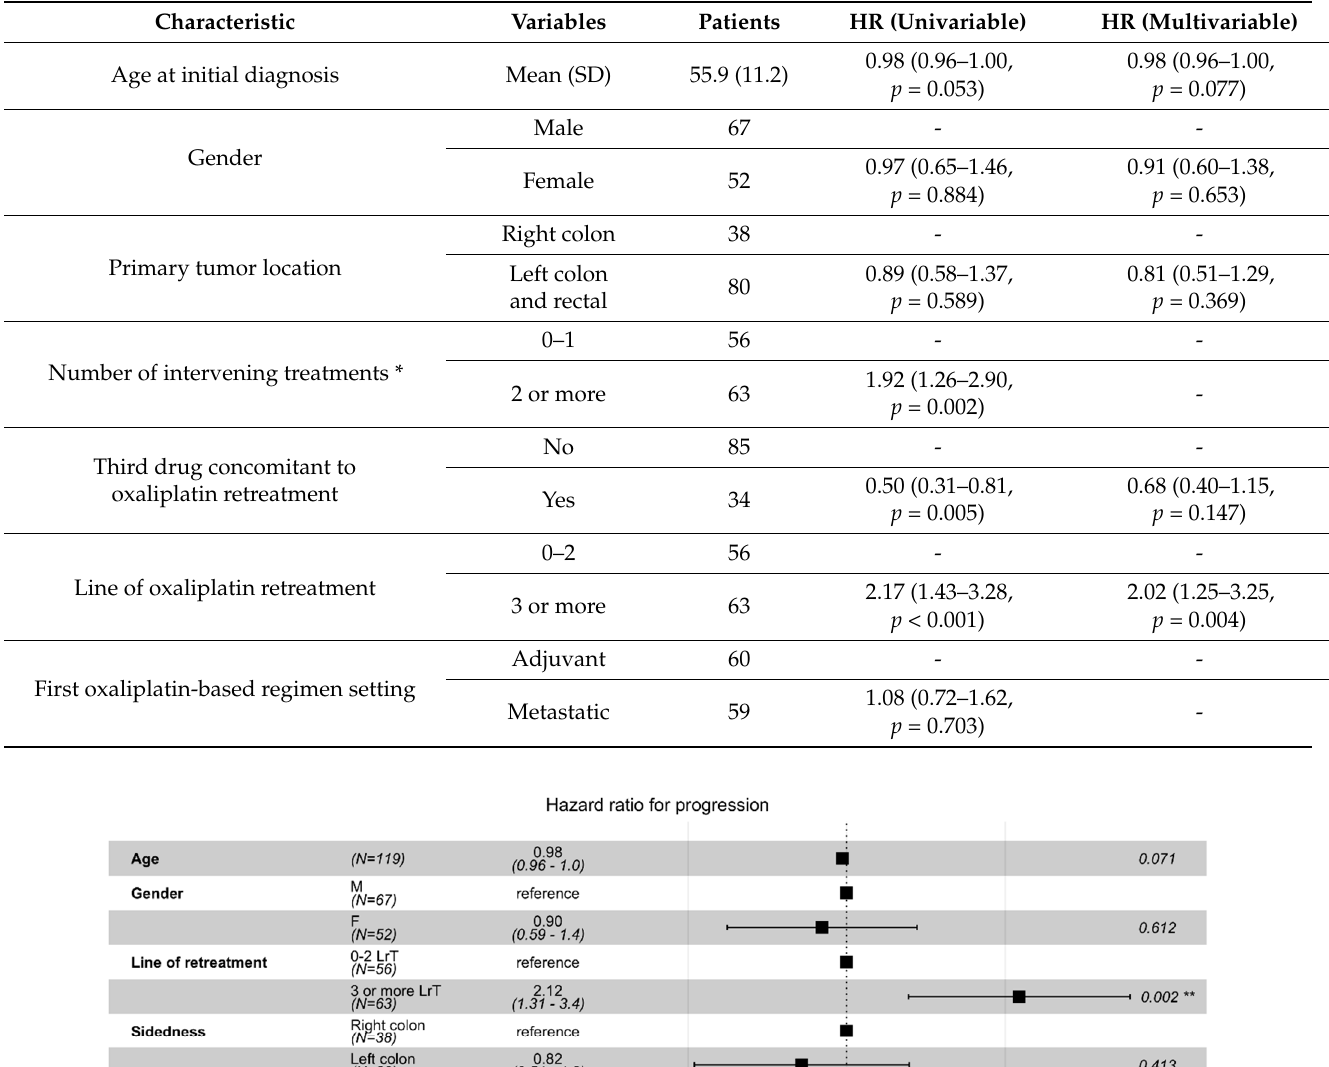
Table 2. Odds ratios at univariate and multivariate analyses of metastatic colorectal cancer pa- tients who were evaluable for median progression-free survival (mPFS) with oxaliplatin retreatment. * = statistically significant.